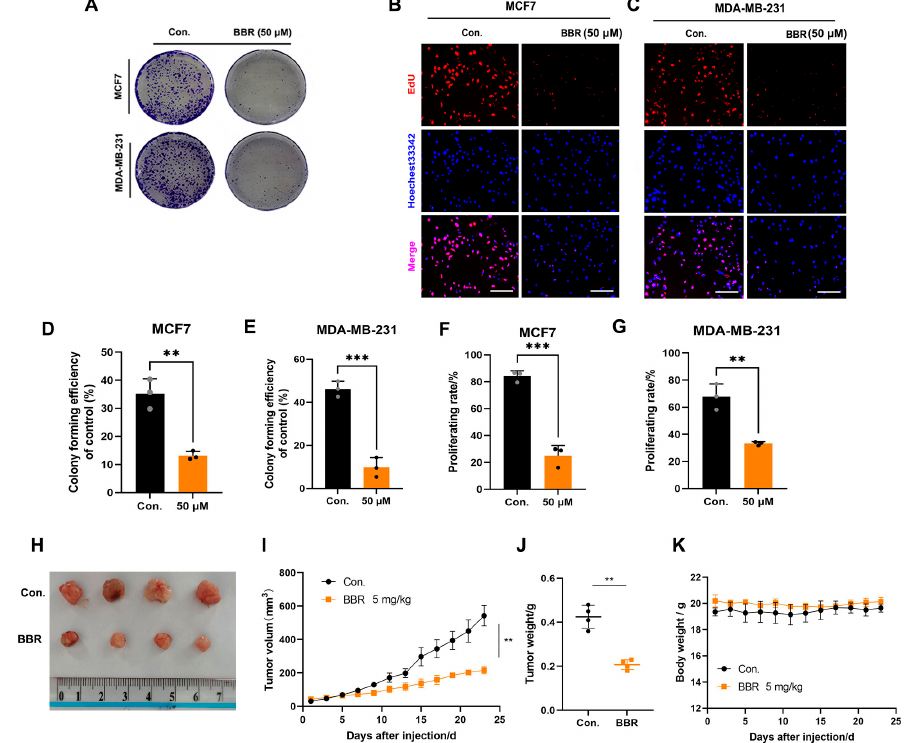
Figure 2. BBR inhibits the proliferation of BRCA cells in vitro and in vivo. The colony formation of MCF7 and MDA-MB-231 cells exposed, with or without BBR ( A ). MCF7 ( B ) and MDA-MB-231 ( C ) cells were incubated with BBR for 24 h, and cell proliferation rates were observed by EdU assay. Statistical analysis of colony formation and EdU experiment. Scale bars: 10 μ m ( D – G ). ** p < 0.01, *** p < 0.001. Data represent the means ± SD of three independent experiments. BBR inhibited xenograft tumor size and tumor weight ( H – J ). No data differences were observed in the mouse body weight ( K ).